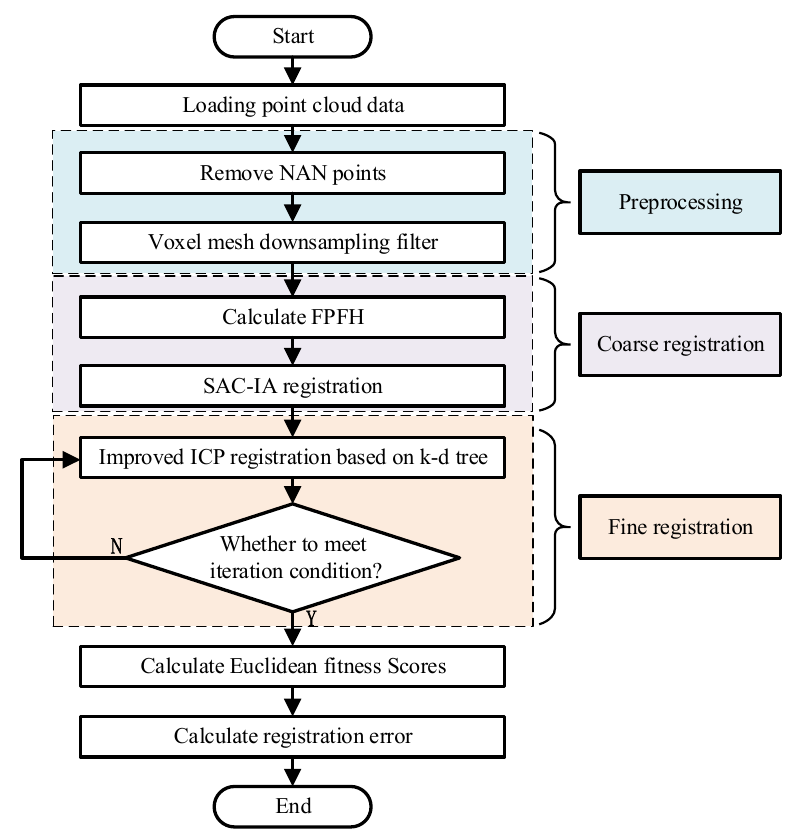
Figure 9. Point cloud registration flow chart.